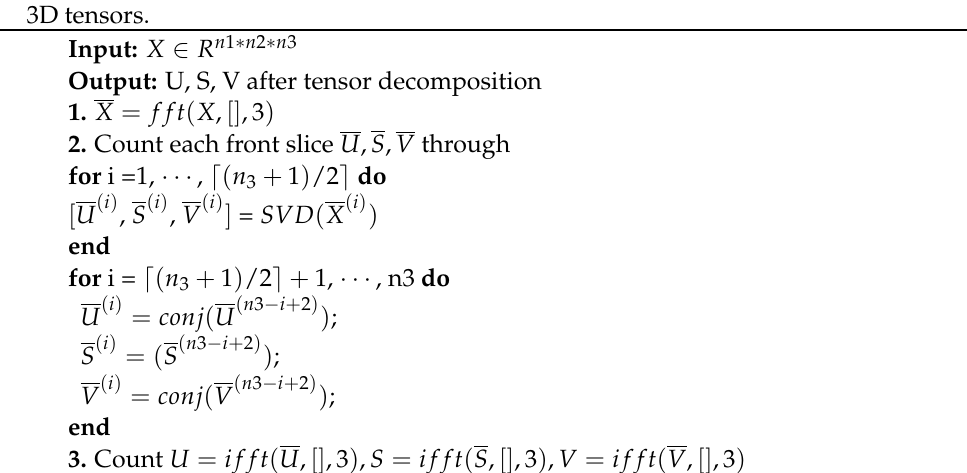
Algorithm 1: Three-dimensional tensor decomposition by t-SVD. t-SVD of 3D